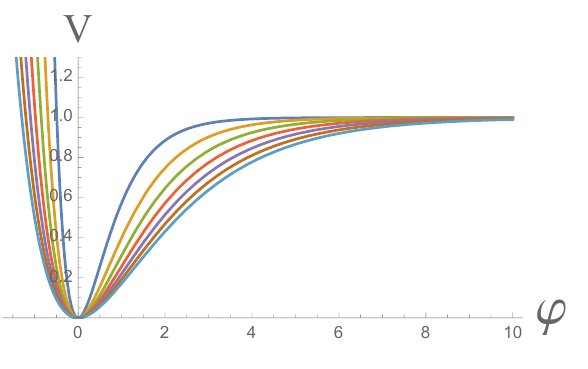
Figure 6 . E-model potentials for 3 (cid:11) = 1 ; 2 ; 3 ; : : : ; 7. The central (blue) line corresponds to 3 (cid:11) = 1. The third line from the center (green) corresponds to the supergravity generalization of the Starobinsky model with (cid:11) = 1 [10, 51]. The outer line shows the potential with 3 (cid:11) = 7. The value of the in(cid:13)aton (cid:12)eld ’ is shown in Planck units M p = 1; the height of the potential is shown in units of m 2